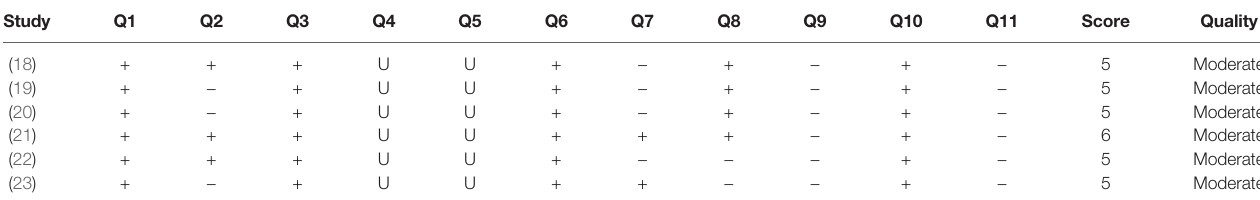
TABLE 3 | AHRQ checklist for assessing the quality of cross-sectional studies.